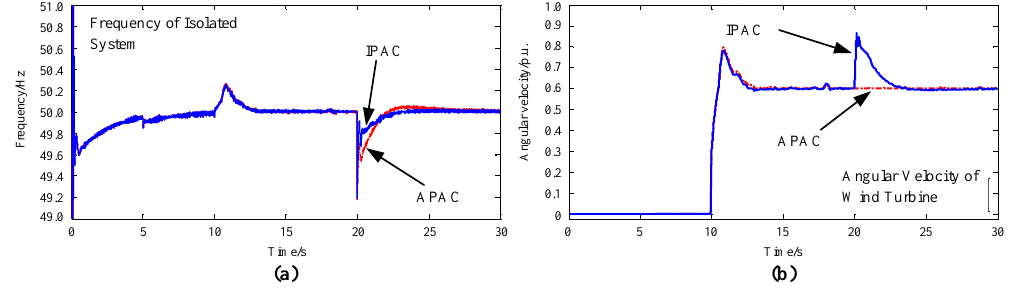
Figure 8. Effect of the improved pitch angular control strategy: ( a ) frequency of the isolated system; ( b ) angular velocity of the wind turbine.